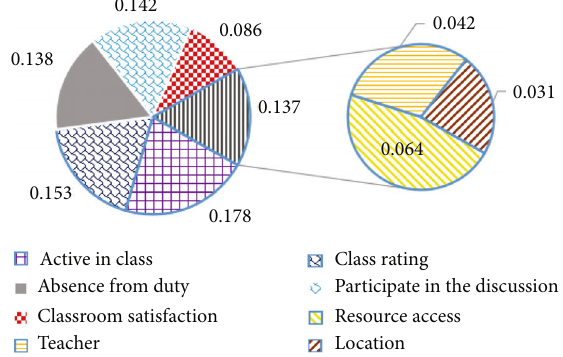
Figure 7: Analysis of in fl uencing factors of students ’ skill